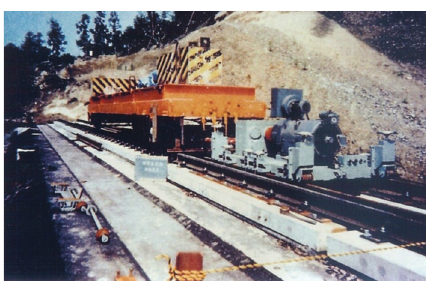
Figure 3: The SBZ 60 cyclic loading